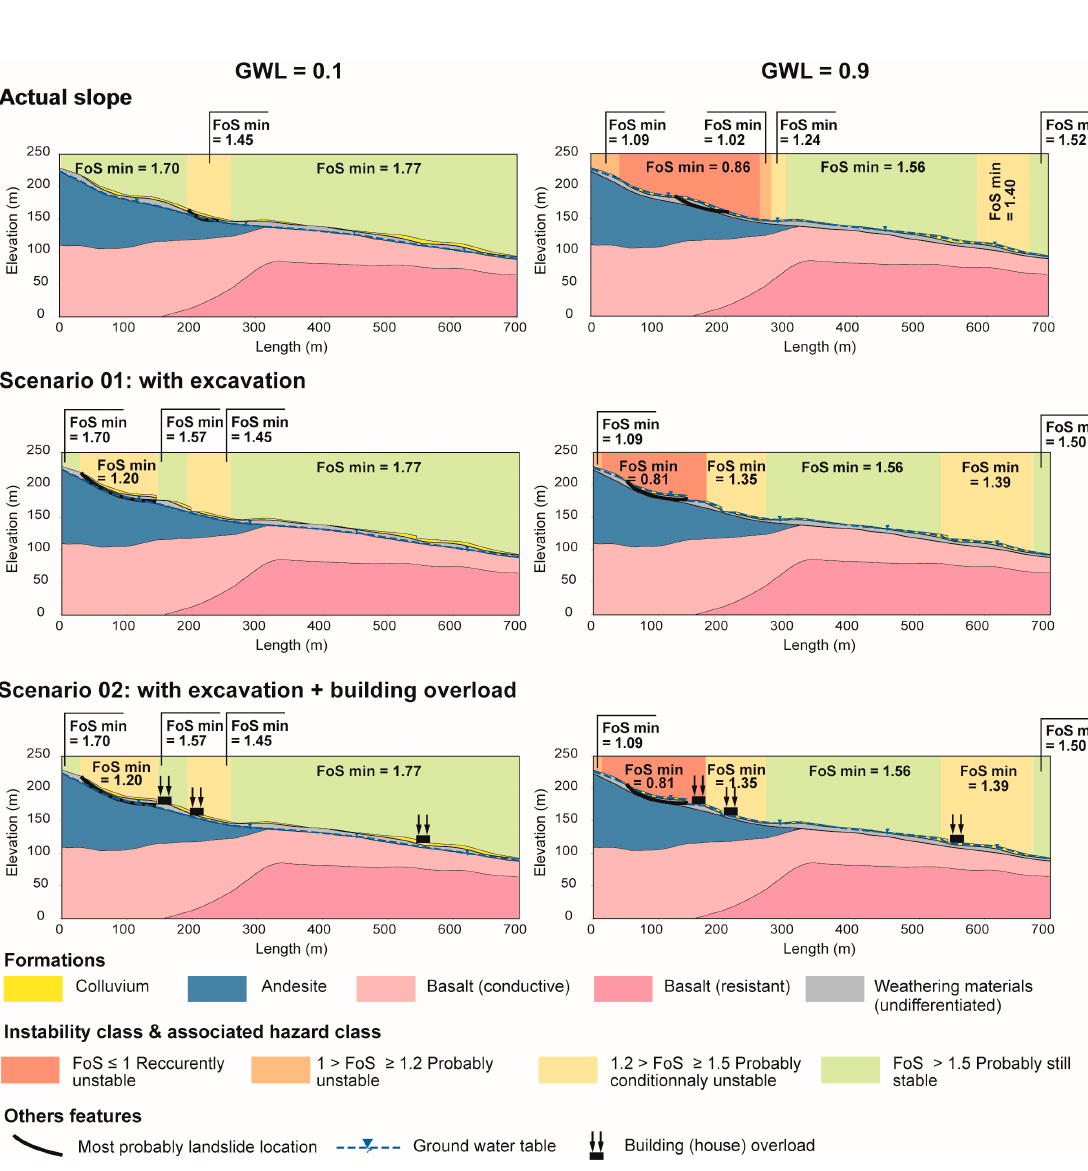
Figure 9. Slope stability analysis for deep landslide (translational + rotational) on representative cross section. The location of the cross section is given in Figure 10.